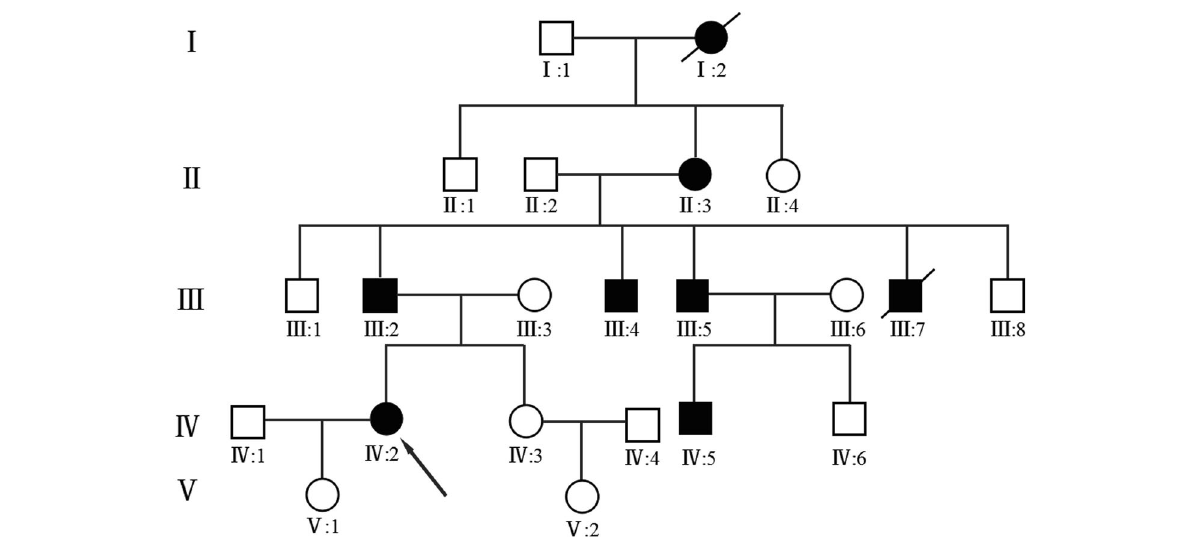
Fig. 1 Pedigree of a five generation family with brachydactyly type A1 (BDA1). Filled symbols represent affected individuals; open symbols unaffected individuals; squares depict males and circles females. Diagonal lines indicate deceased individuals. The proband is indicated by an